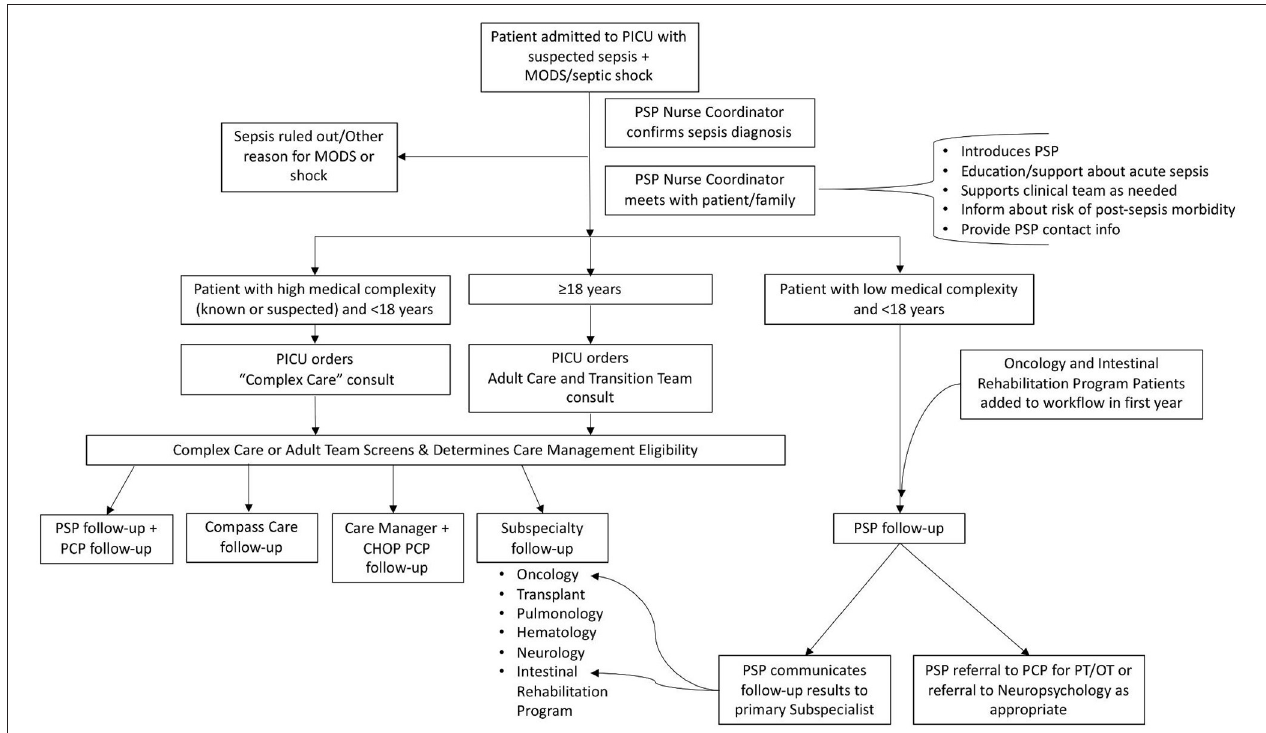
FIGURE 2 | Updated sepsis survivorship workflow. The follow-up workflow was updated during the first year of the program. PICU, Pediatric Intensive Care Unit; MODS, multiple organ dysfunction syndrome; PSP, Pediatric Sepsis Program; PCP, primary care provider; CHOP, Children’s Hospital of Philadelphia; PT/OT, physical therapy/occupational